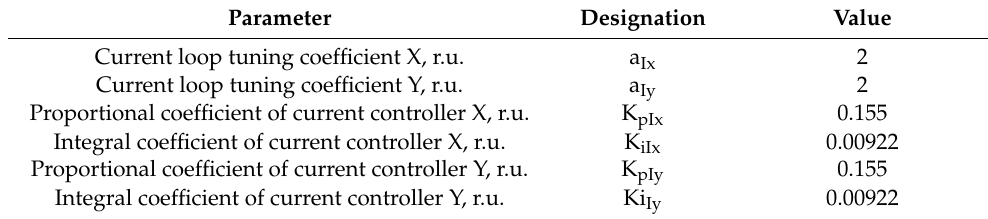
Table 1. Parameters of AD914U1 (A Д 914 У 1) traction motor. Parameter Value Power P, kW 1200 Phase-to-phase RMS voltage U nom , V 1870 RMS value I nom , A 450 Rated frequency of the supply voltage f, Hz 55.8 Number of phases n, pcs. 3 Number of pole pairs p p 3 Nominal rotational speed n r , rpm 1110 Efficiency η , % 95.5 Power factor cos ϕ , per unit 0.88 Active resistance of the stator winding r s , Ω 0.0226 Active resistance of the rotor winding reduced to the stator winding r (cid:48) r , Ohm 0.0261 0.00065